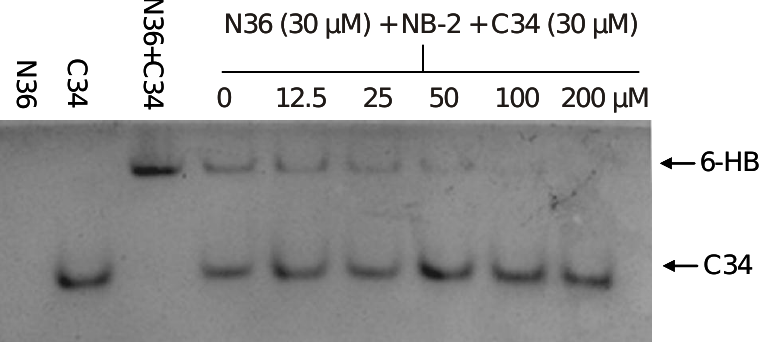
Figure 2. NB-2 inhibits 6-HB formation in a dose-dependent manner, as assessed by N-PAGE. NB-2 at different concentration was mixed with N36 at 37 °C for 30 min before addition of C34. After incubation for another 30 min, the mixture was analyzed by N-PAGE. As shown in this figure, N36 showed no band (lane 1), C34 showed a single band in the lower portion of the gel (lane 2), and the mixture of N36 and C34 showed a band in the upper portion of the gel corresponding to the band for 6-HB (lane 3). In the presence of increasing concentration of NB-2, the bands of the 6-HB formed between N36 and C34 (upper bands in lanes 4–9) become weaker and weaker than that without NB-2 (upper band in lane